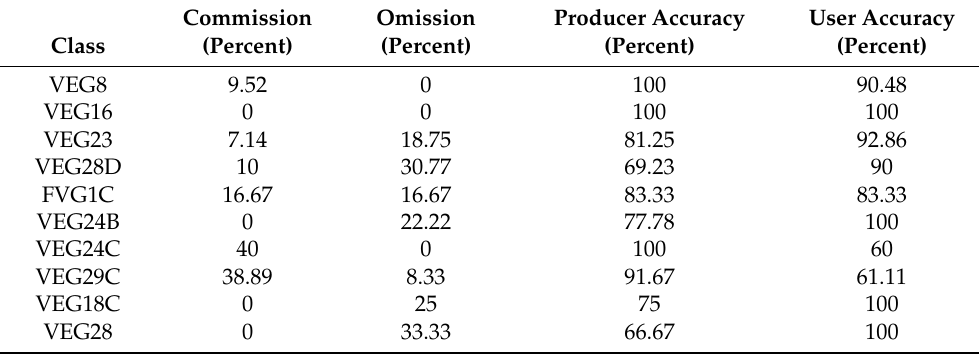
Table A6. The producer and user accuracies from the classifier performance as well as the percentage of ground truthing ROIs that were either omitted from or committed to the eventual expected